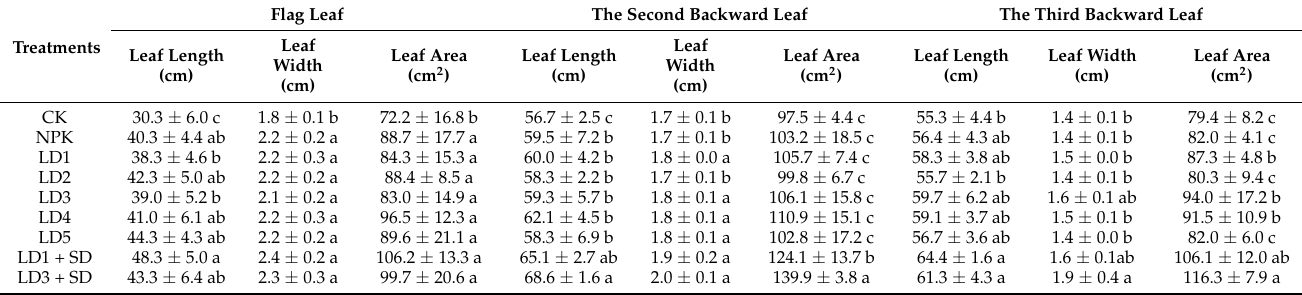
Table 2. The leaf length and width and leaf area of rice plants under different treatments, respectively.